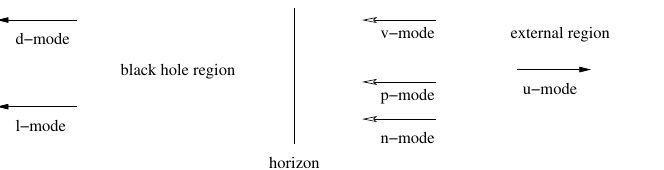
Figure 1. Particles’ modes involved in the subluminal case. IN modes are indicated by means of thin arrows, whereas OUT modes are indicated by means of thick arrows. The black hole horizon is indicated by a vertical